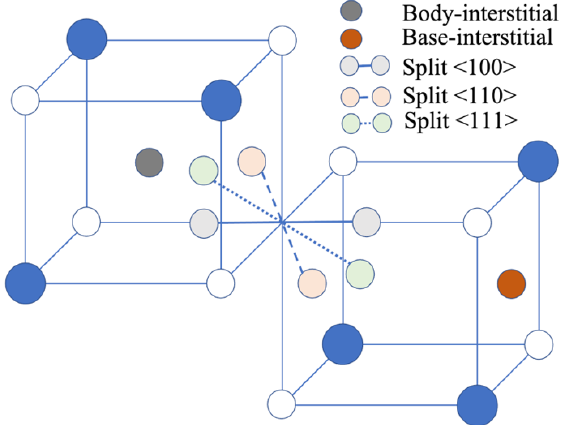
Figure 1. Interstitial configurations in binary rock-salt. Solid blue and open blue atoms represent cations and anions, respectively.